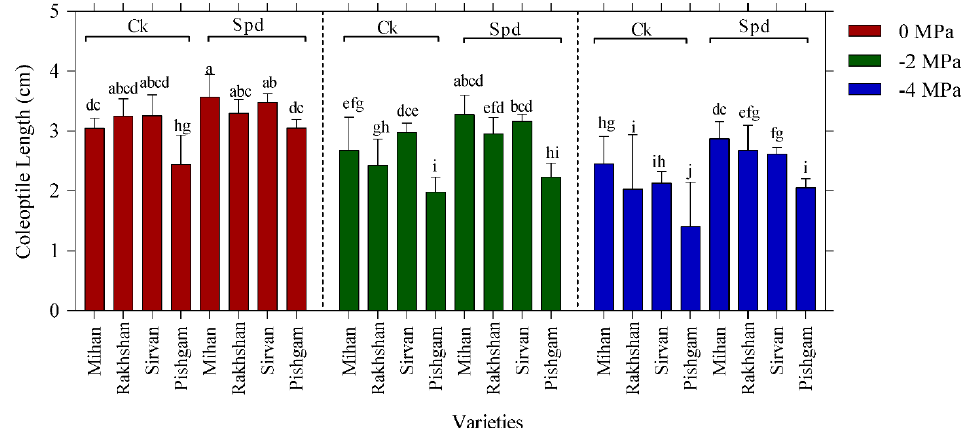
Figure 3. Effect of spermidine (Spd) on coleoptile length of four wheat varieties under drought stress with three levels of PEG 6000 osmotic potential (−2, −4 MPa and 0 using distilled water as control). Ck = distilled water. Different letters indicate statistically significant differences across all three levels of PEG 6000 at p < 0.05 level using LSD’s test.